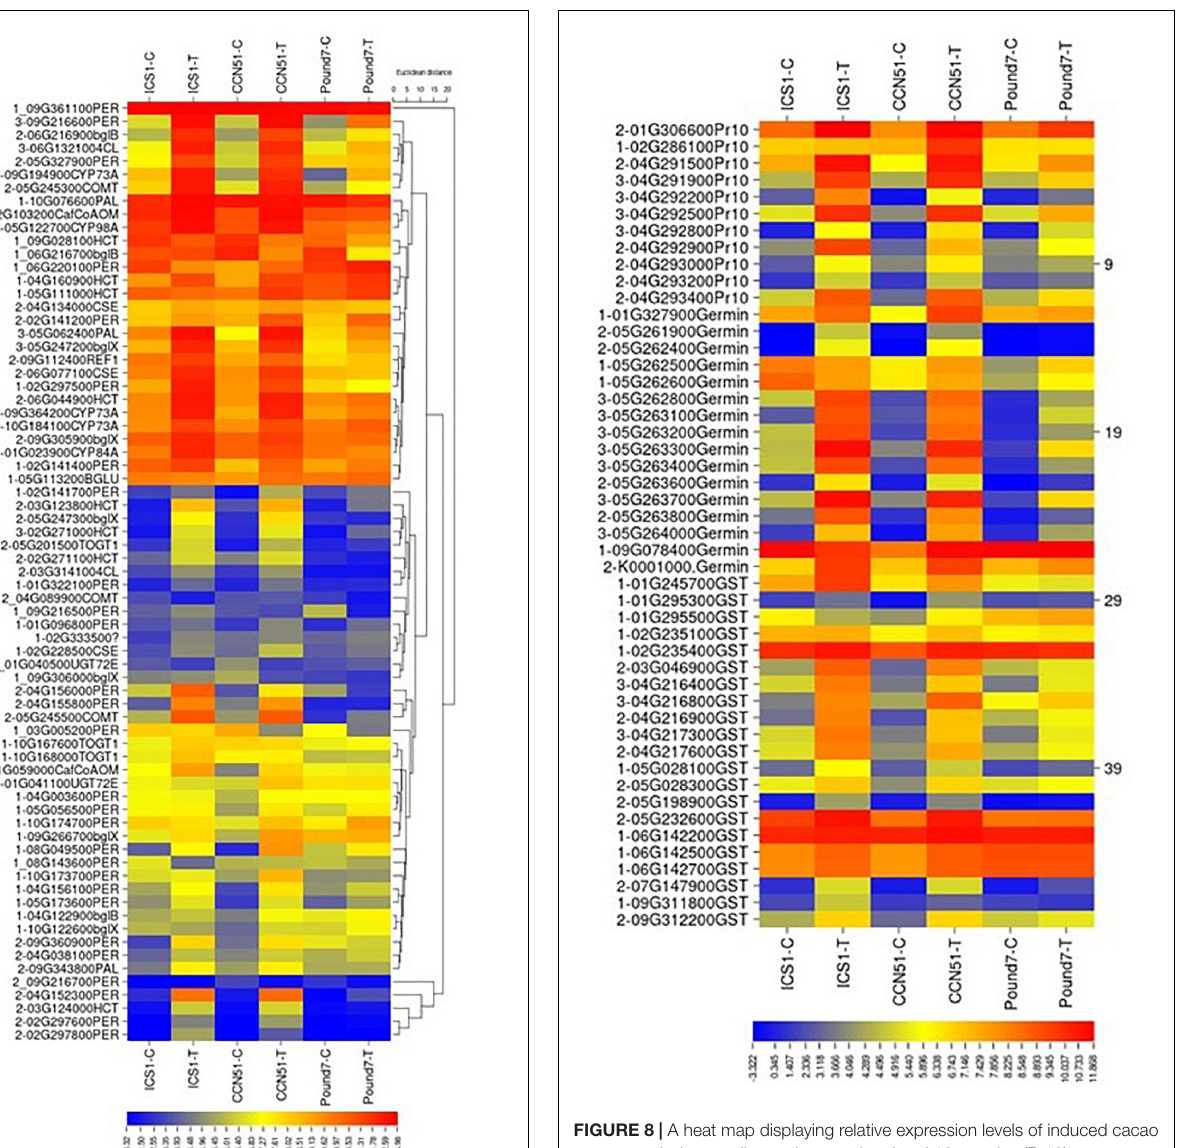
FIGURE 8 | A heat map displaying relative expression levels of induced cacao gene, putatively encoding pathogenesis-related 10 proteins (Pr10), Germin-like proteins (Germin), glutathione S-transferase-related proteins (GST) in young red leaves of ICS1, CCN51, and Pound7 24 h after inoculation with ( Table 3 ): 229 in Pound7, 121 in CCN51, and 182 in